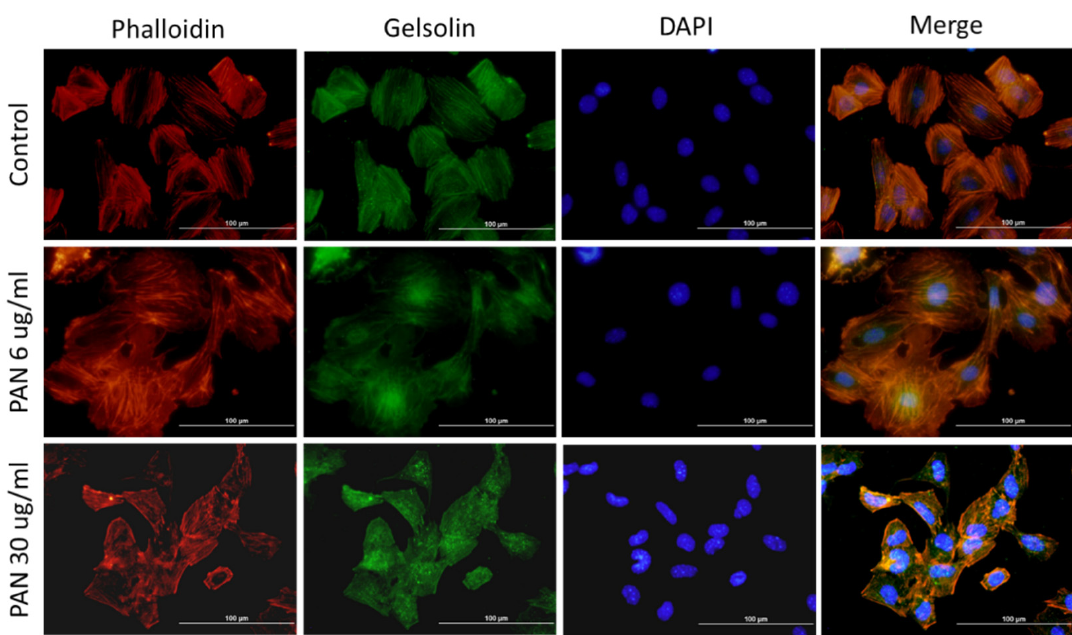
Figure 3. Immunofluorescence staining images of podocytes. Phalloidin staining showed that PAN exposure-induced actin cytoskeleton rearrangement in podocytes and gelsolin proteins co-localize with actin filaments. (PAN = Puromycin aminonucleoside).